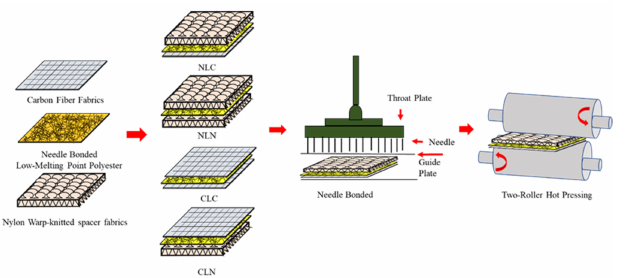
Figure 1. Preparation steps used for carbon fiber composites containing an LMPET nonwoven fabric as a